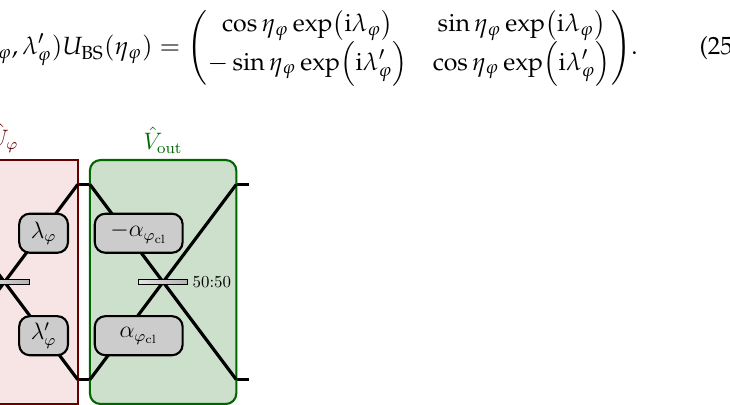
= ( λ ϕ ) /2 λ (cid:48) ϕ π /4 cl cl − − cl and λ (cid:48) ϕ . Reprinted with permission from ref. cl cl